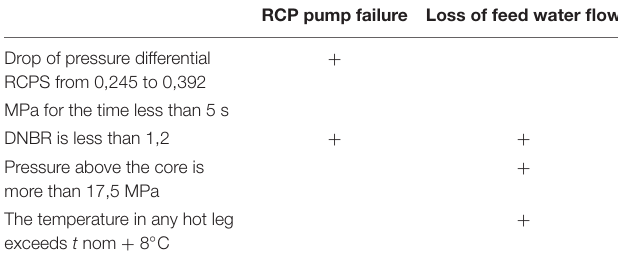
TABLE 3 | Reactor SCRAM conditions.